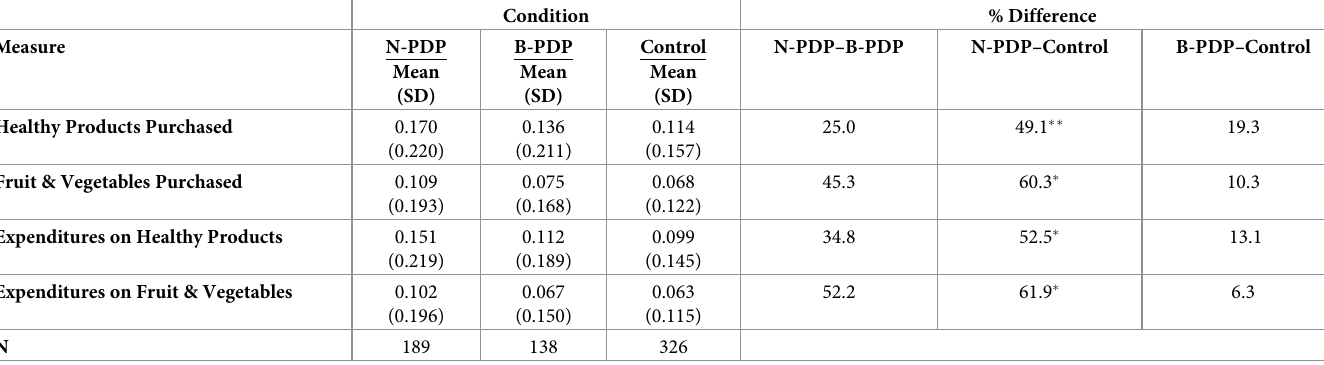
Table 2. Purchases of healthy foods in N-PDP, B-PDP, and control